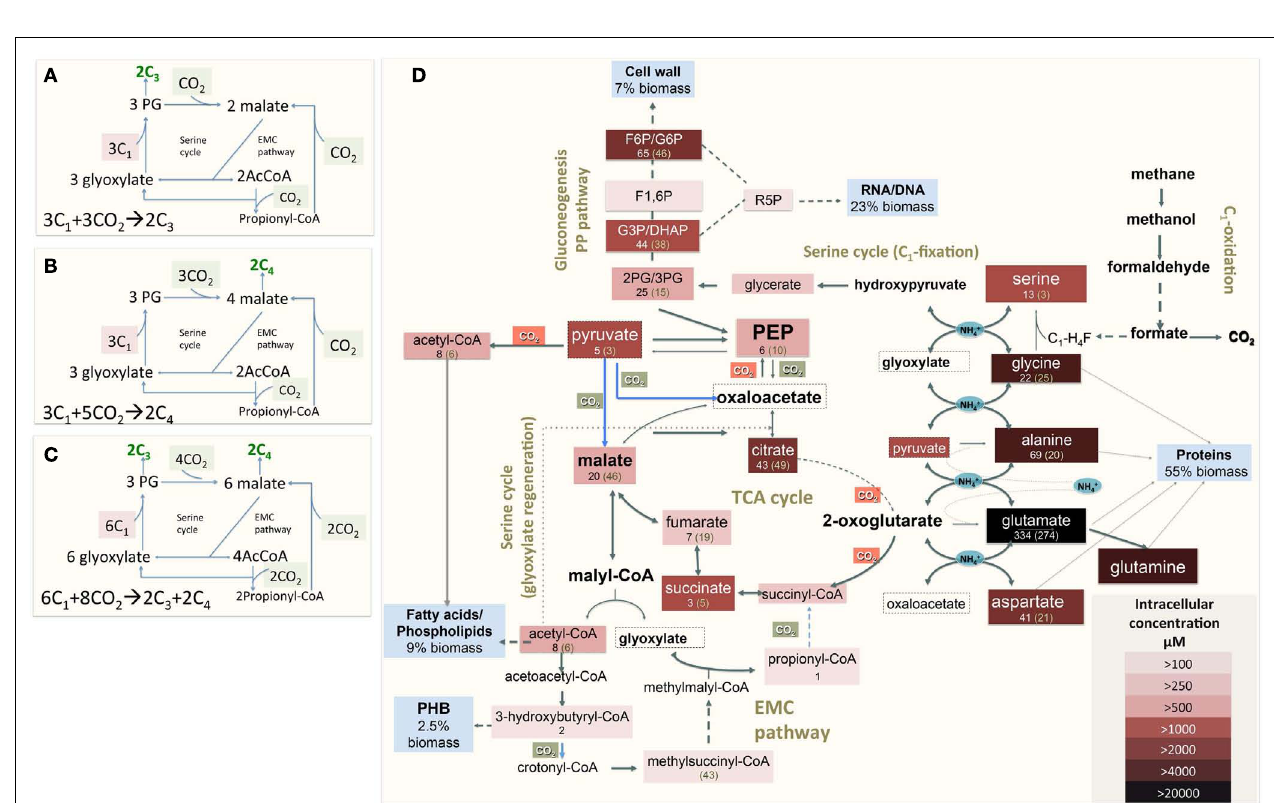
boxed were measured. Box color is an indicator of the metabolite pool, with darker colors indicating a larger pool. Numbers under a